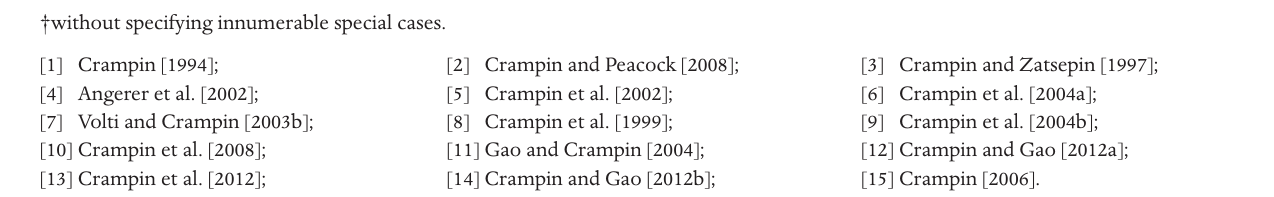
Table 3. Evidence supporting APE deformation and the New Geophysics of a compliant calculable stress-sensitive microcracked rock